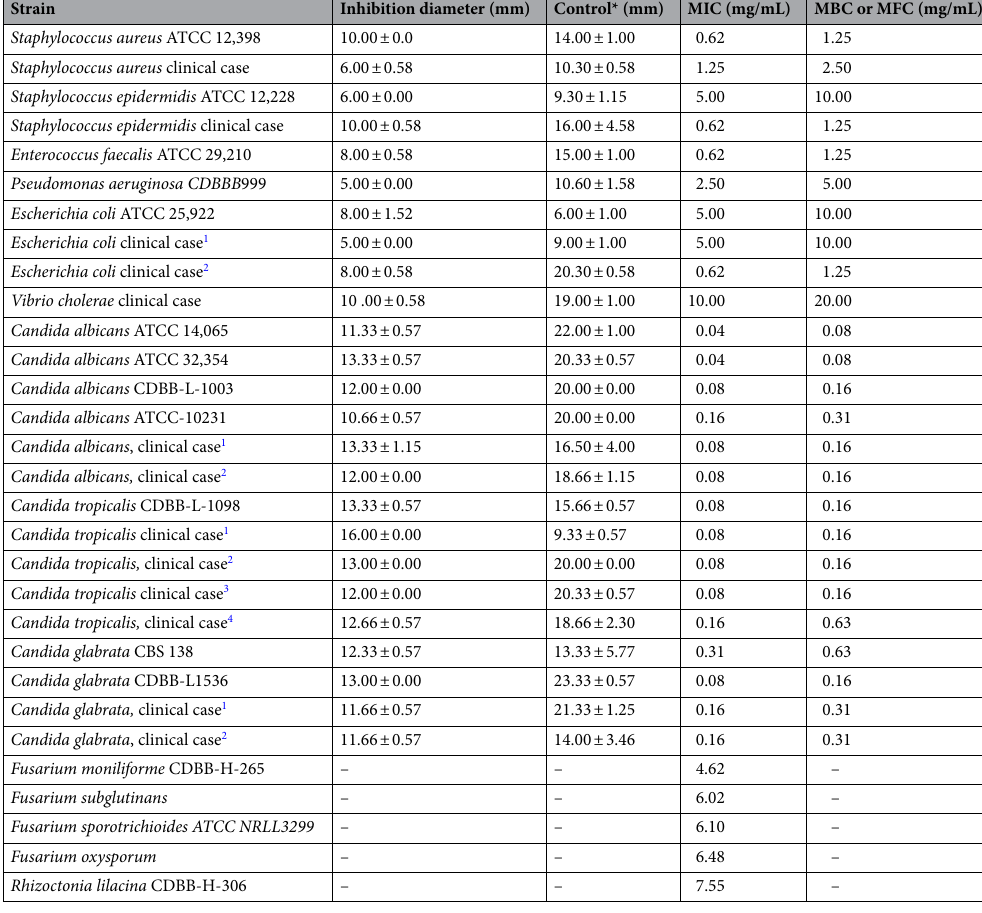
Table 2. Antimicrobial activity of the methanolic extract of P. laevigata leaves. *Bacterial positive control: chloramphenicol 25 μg/disk; yeast positive control: nystatin 25 μg/disk. (−): no